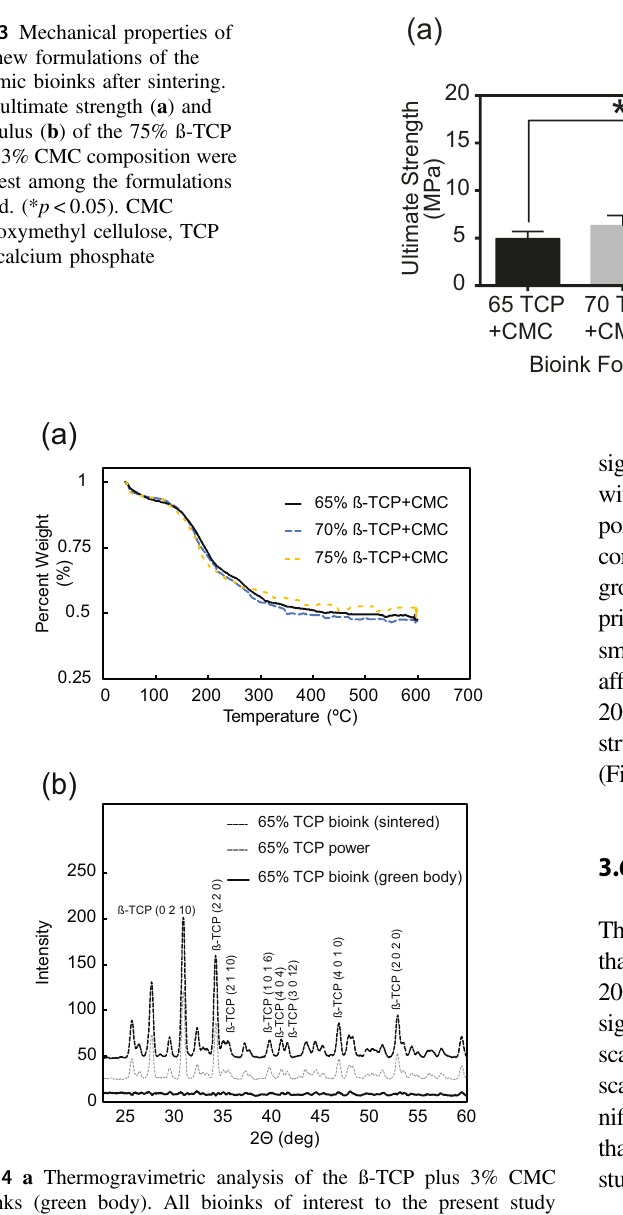
Fig. 4 a Thermogravimetric analysis of the ß-TCP plus 3% CMC bioinks (green body). All bioinks of interest to the present study exhibited similar loss of mass with respect to temperature due to water and gelatin loss. All bioinks reached an equilibrium at 600 °C. b XRD spectra of the 65% TCP plus CMC bioink as green body and after sintering compared to pure TCP powder. CMC carboxymethyl cellu- lose, TCP ß-tricalcium